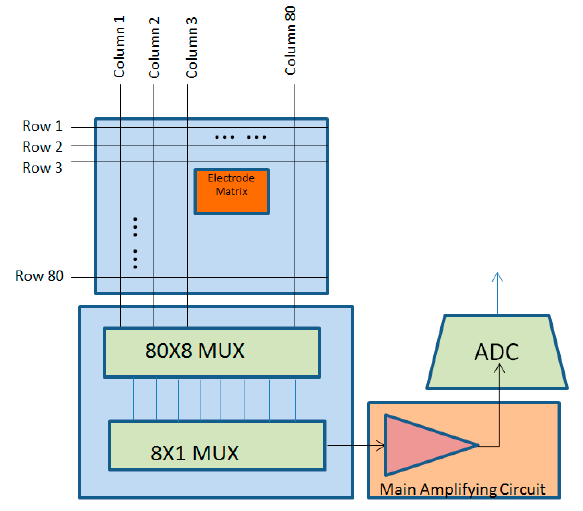
Figure 6. Electrostatic fingerprint sensor signal processing.